Question: Write a caption explaining this figure to a reader.
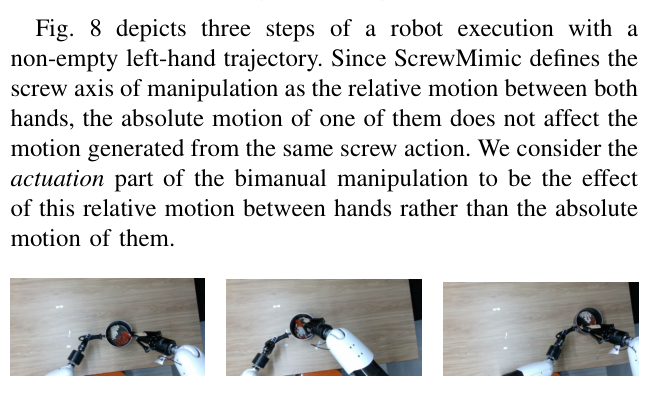
Answer: Screw Action execution with left-hand trajectory Three steps of a robot execution of a stir task with non-zero left-hand motion. Since SCREWMIMIC focuses on the generation of relative motion between hands, the same screw action can be used even when there exists any absolute motion of one of them (left hand).